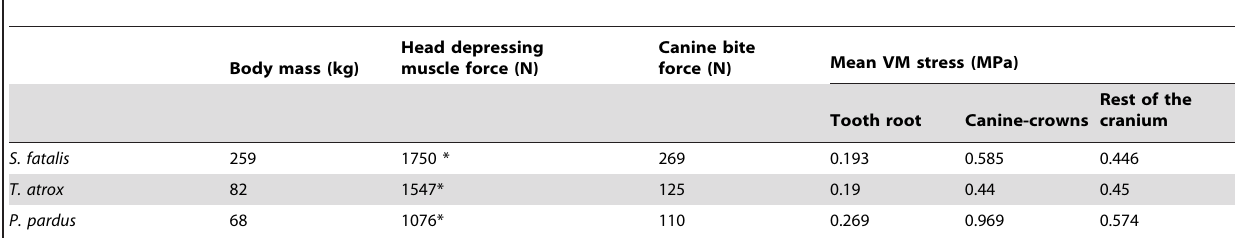
Table 2. Body-mass-scaled bite-force results and mean brick VM stresses for selected regions in for a cervical-musculature-driven bite.